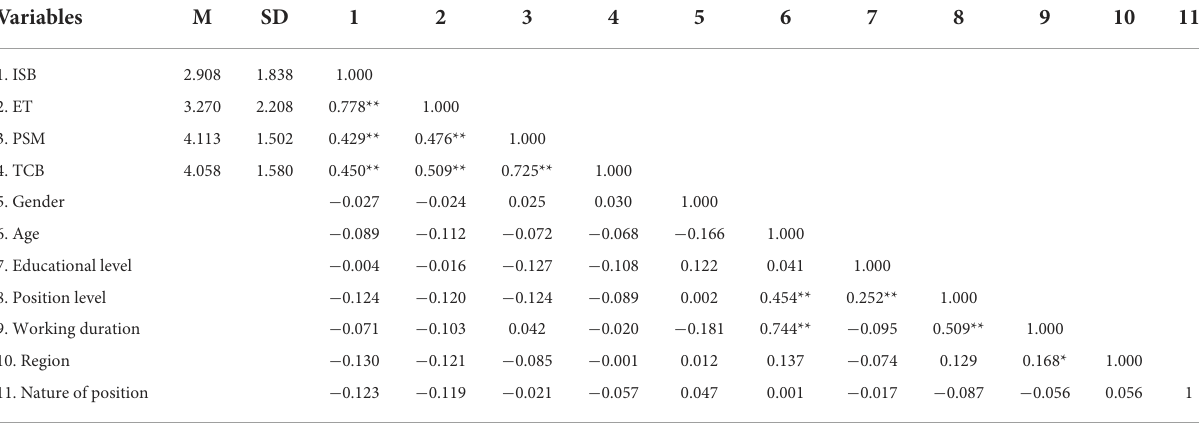
TABLE 3 Testing of mediation effect and moderation effect.